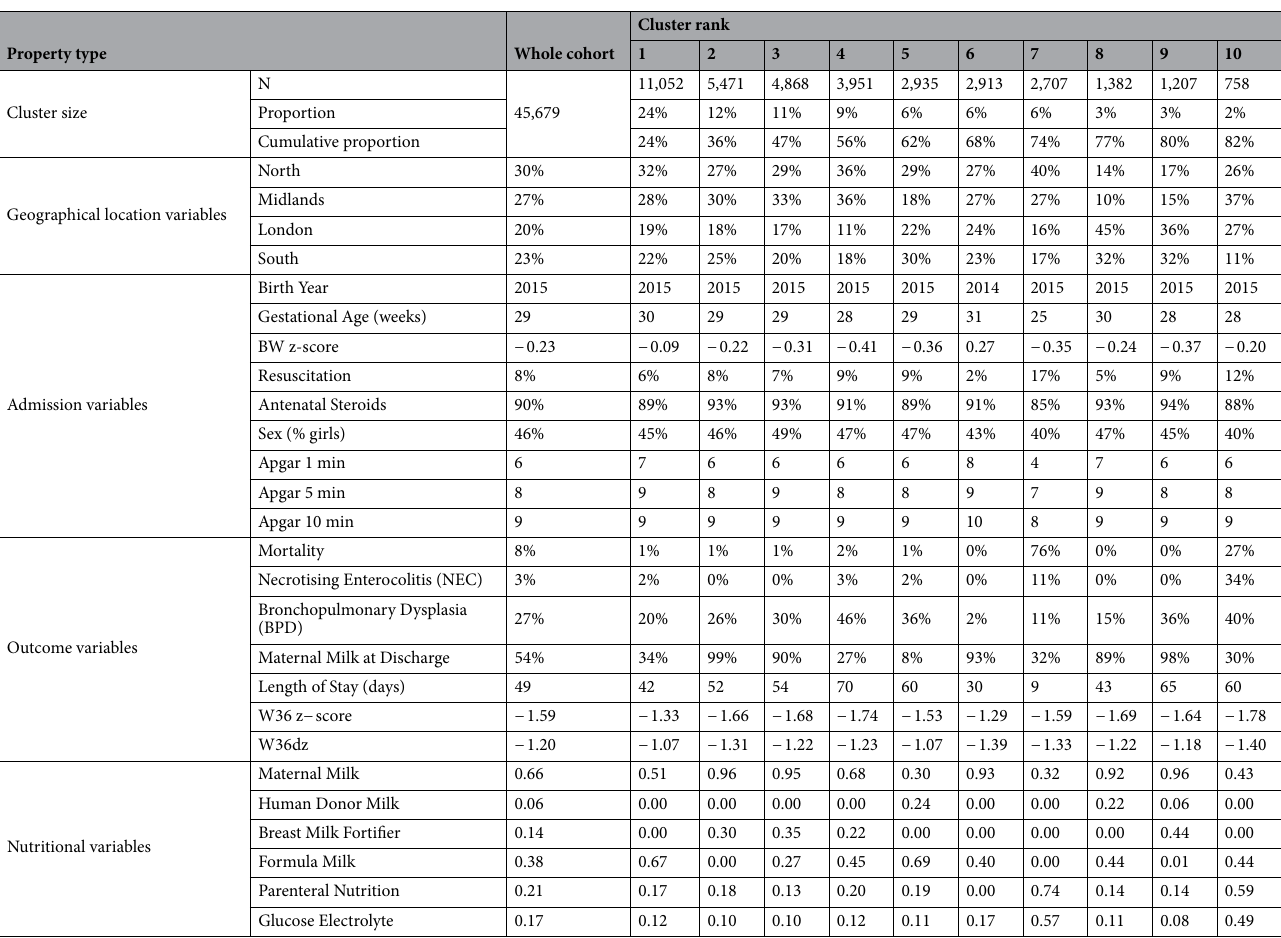
Table 2. Statistics on the within-cluster populations of the 10 most common nutritional patterns and the whole cohort. Clusters are ranked according to population size (1 = largest cluster). All variables are reported as median values, except for proportions which are means. Proportions are reported as integer values, therefore 0% corresponds to < 0.5% and the sum across the geographical location variables may not be exactly 100%. Nutritional variables encode the nutritional patterns through the proportion of days a nutritional component was given over the total time in care (between 0 and